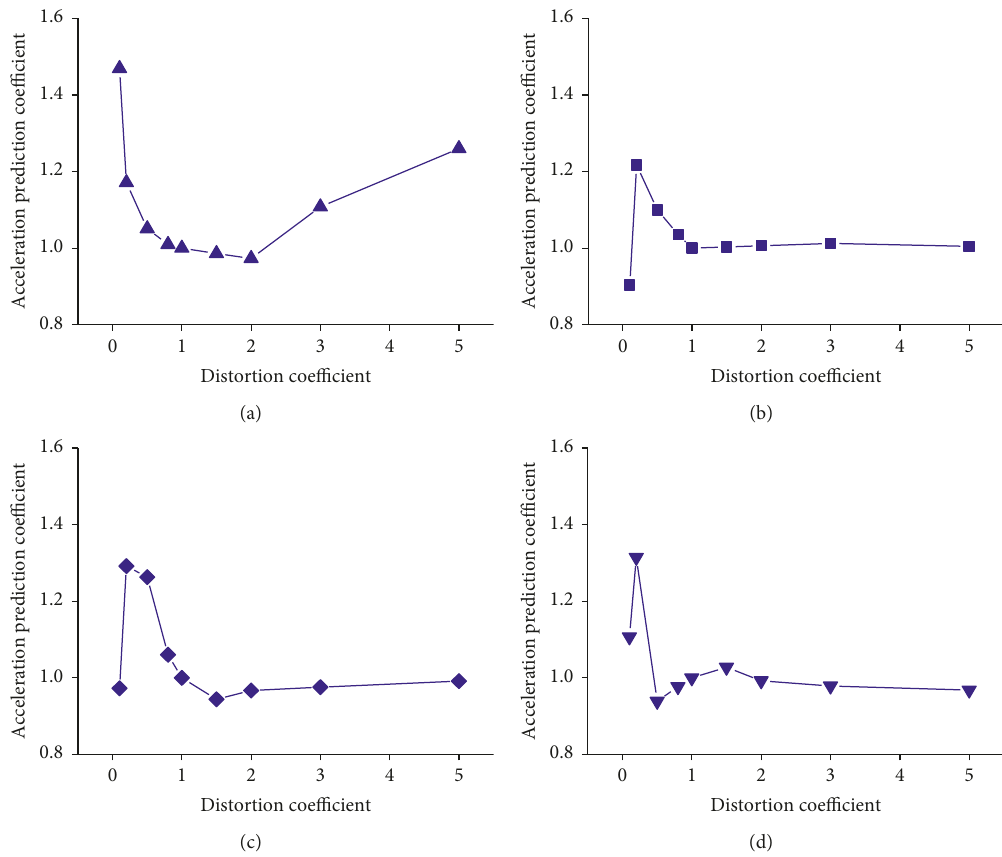
Figure 4: Acceleration prediction coefficient results under different distortion coefficients. (a) EL Centro. (b) Taft. (c) Northridge. (d)